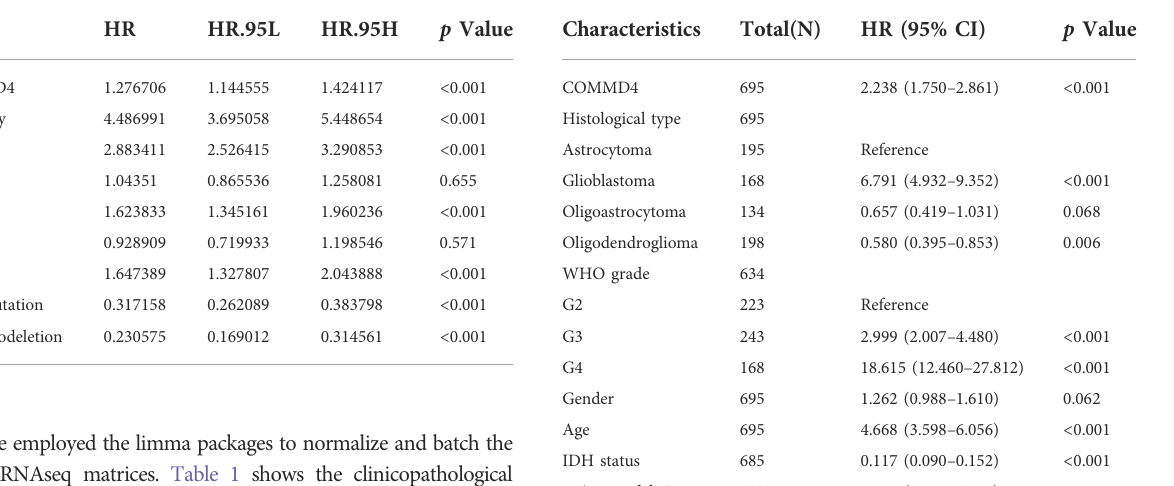
TABLE 2 Cox analysis of the CGGA database. TABLE 3 Cox analysis of the TCGA